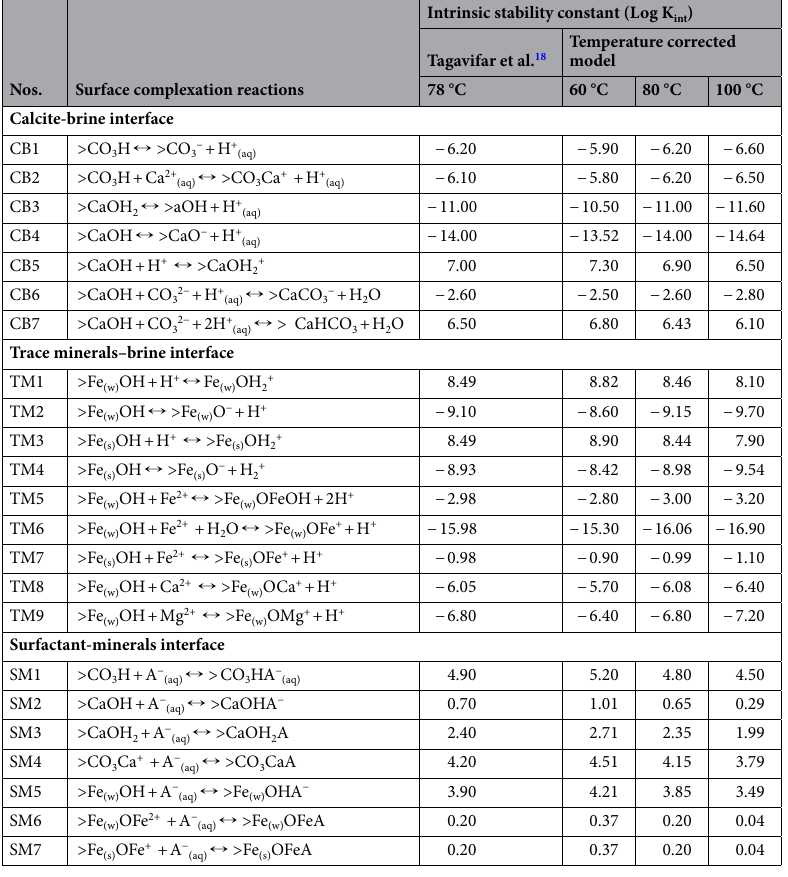
Table 1. Surface complexation reactions used with intrinsic stability